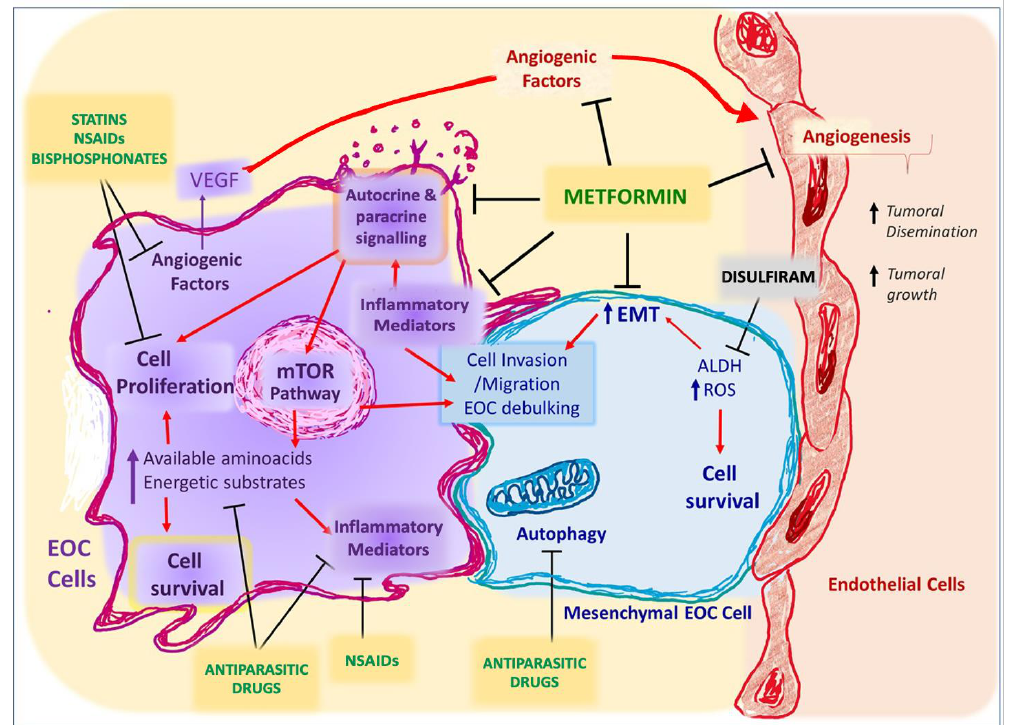
Figure 3. Repurposed drugs with anti-tumoral effects in epithelial ovarian cancer cells (in vitro and in vivo) and their molecular targets. EOC: epithelial ovarian cancer. VEGF: vascular endothelial growth factor. EMT: epithelial-mesenchymal transition. ALDH: aldehyde dehydrogenase. ROS: reactive oxygen species. NSAIDs: non-steroidal anti-inflammatories.